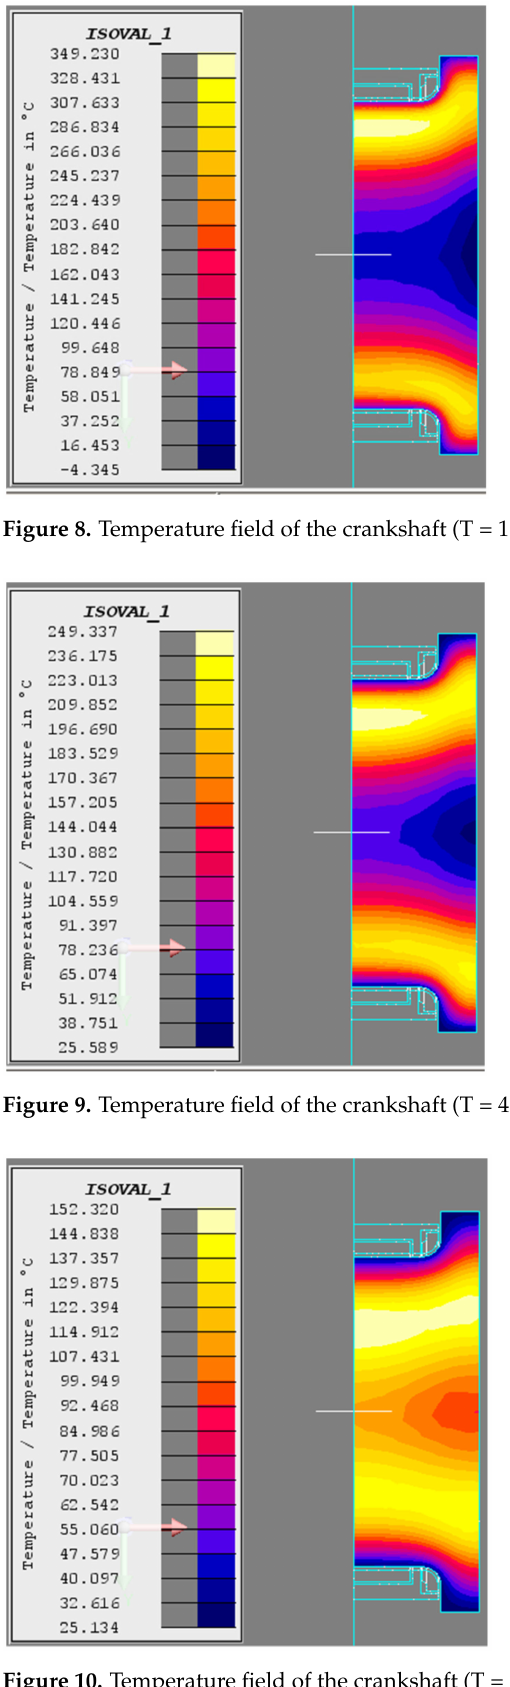
Figure 10. Temperature field of the crankshaft (T = 7